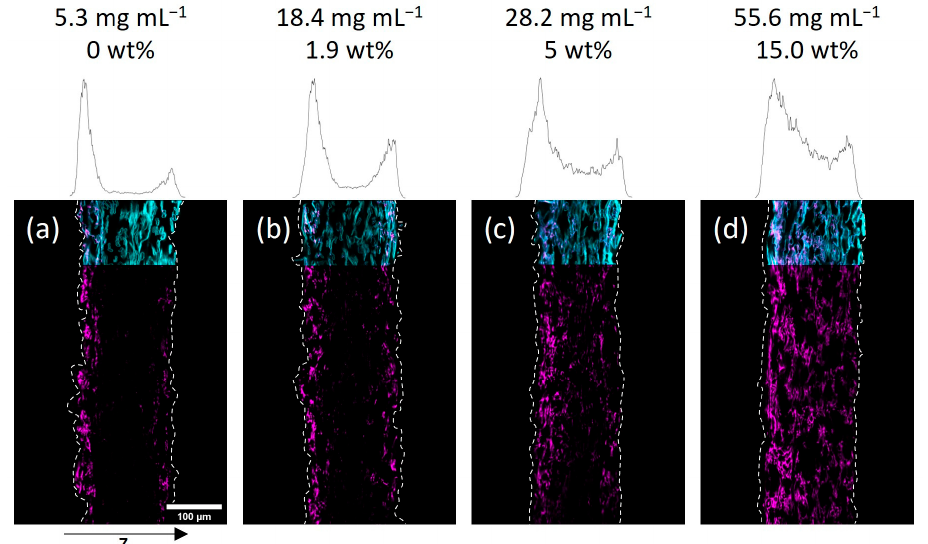
Figure 4. Cross-sections of paper samples modified with the photo-cross-linkable copolymer dissolved in IPA at different concentrations as indicated, acquired by fluorescence CLSM. The fibers are stained with FB (cyan color) and the copolymer fluoresces due to the rhodamine B label (magenta). The left side of the images corresponds to the side that was facing upwards during drying and UV-excitation of samples. The z-distribution of the copolymer fluorescence is shown above each cross-section. For easier comparison, the corresponding concentrations of polymer solutions and the gravimetrically determined amount of copolymer are also noted: 5.3 mg mL − 1 , 0 wt% ( a ); 18.4 mg mL − 1 , 1.9 wt% ( b